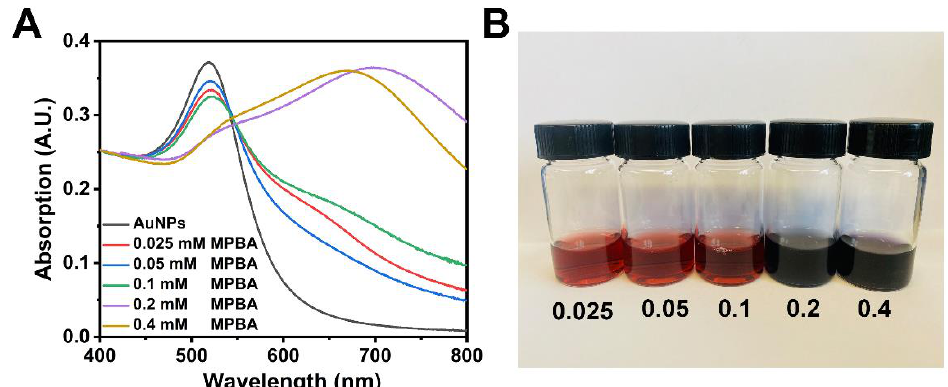
Figure 3. ( A ) UV–Vis absorbance responses of the AuNPs modified with increasing concentration Figure 3. ( A ) UV – Vis absorbance responses of the AuNPs modified with increasing concentration from 0.025 to 0.4 mM 4-MPBA. ( B ) Photographs of their corresponding samples. from 0.025 to 0.4 mM 4-MPBA. ( B ) Photographs of their corresponding